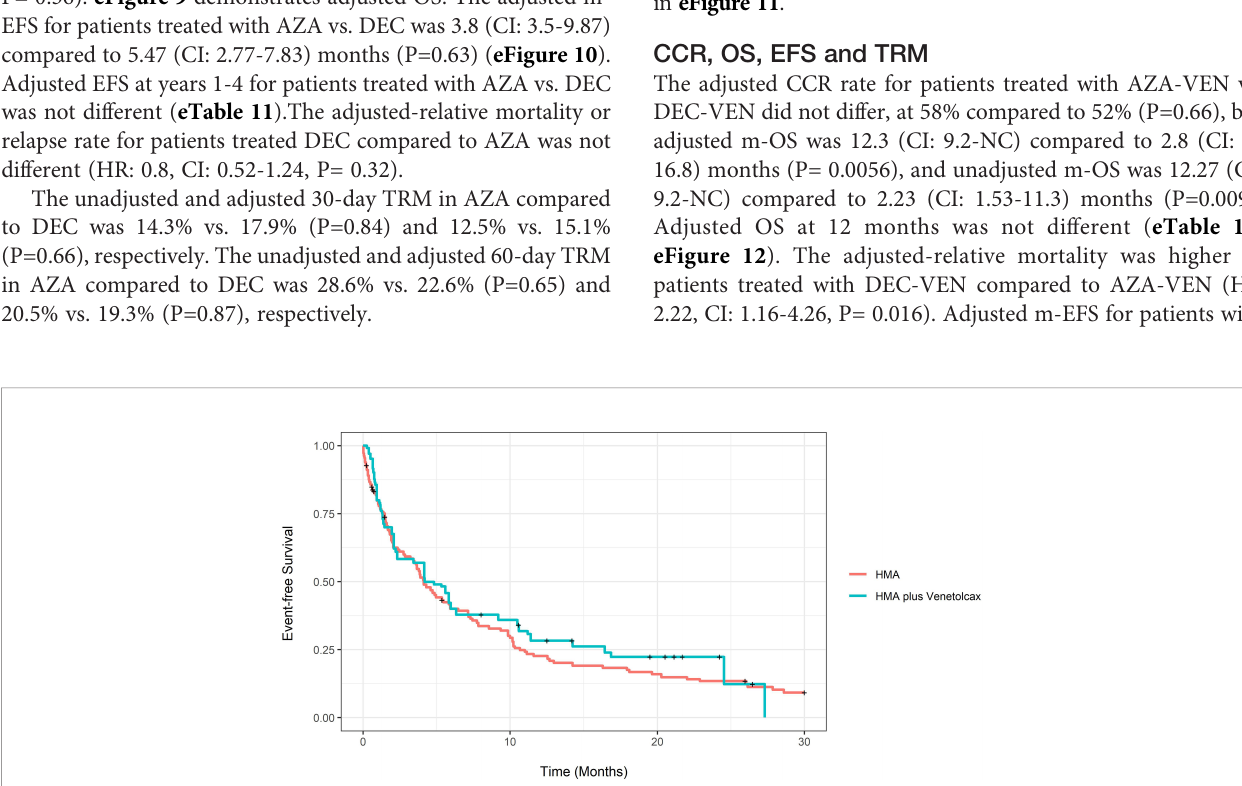
FIGURE 4 | Propensity score-adjusted event-free survival of newly diagnosed acute myeloid leukemia patients treated with hypomethylating (HMA) vs. HMA plus